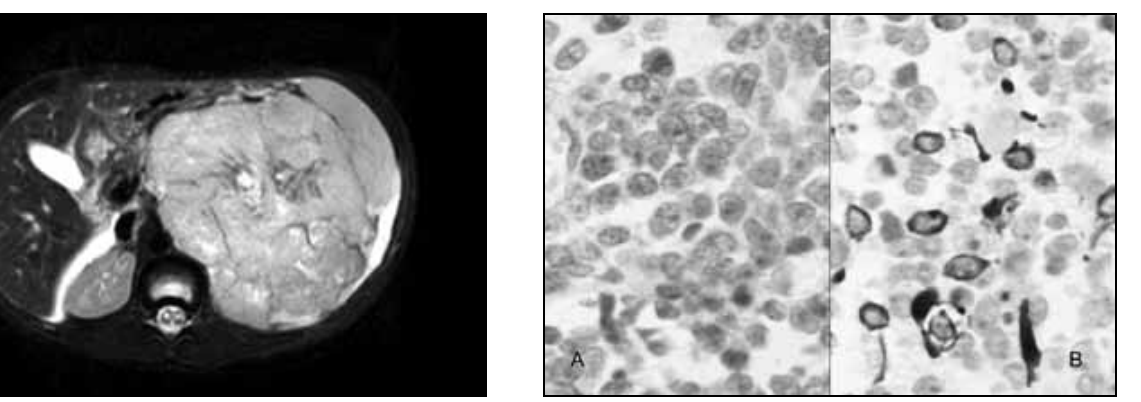
Figura 2 – Ressonância magnética de abdome evidenciando presença de grande massa retroperitoneal à esquerda, com deslocamento anterior do baço